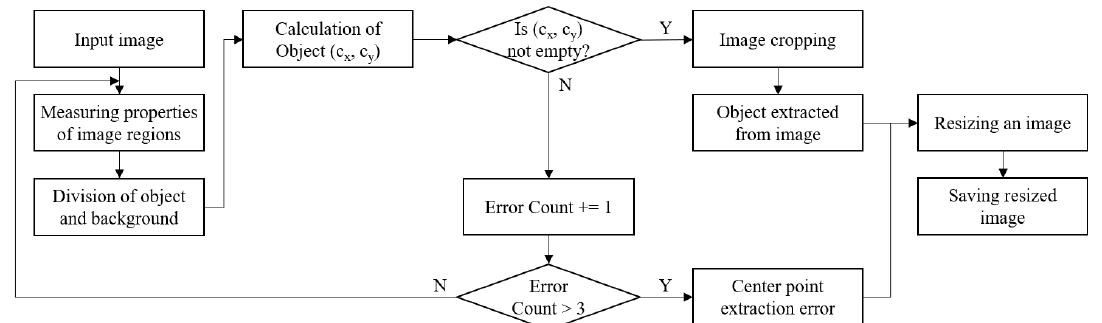
Figure 6. Process of the ROI